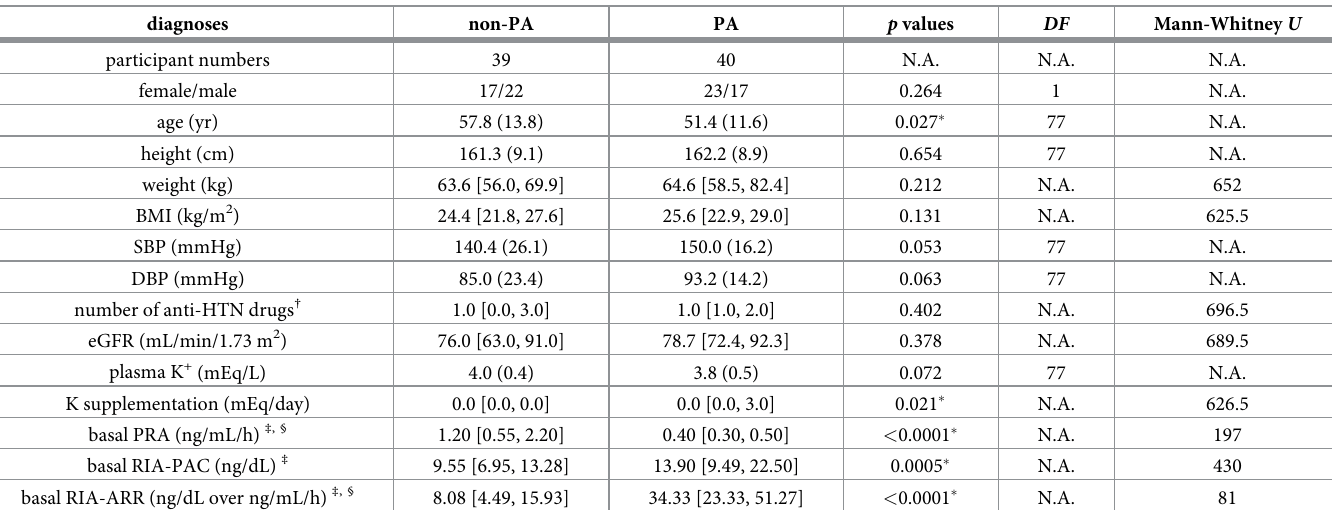
Table 2. Clinical characteristics of participants.